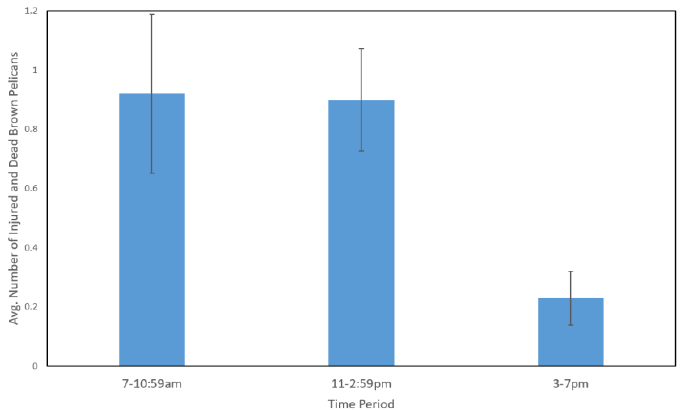
Figure 3. Estimated marginal mean (SE bars) number of injured and dead Brown Pelicans during three times of day after controlling for the other variables in the model. The 7 – 10:59 am and 11 – 2:59 pm time periods had significantly more injured and dead pelicans than the 3 – 7 pm time period ( p < 0.05, LSD post hoc test). Sample size = 144 surveys.